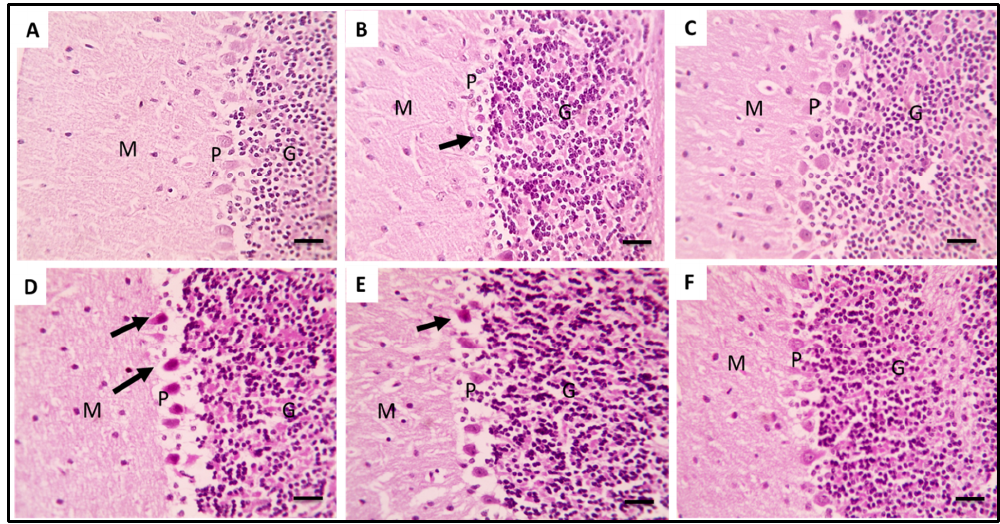
Figure 11. H&E-stained brain sections showing the cerebellum of the different groups. Normal neu- rons were revealed in the control group (group 1, ( A )). Sections from the group that received LPS (group 3, ( B )) showed a severe loss of purkinje neurons (black arrow). Sections from the treated group with RVS (group 4, ( C )) showed normal purkinje neurons. Sections from the treated group with SPE 100 mg/kg (group 5, ( D )) showed markedly degenerated purkinje neurons (black arrows). Sections from the treated group with SPE 200 mg/kg (group 6, ( E )) showed a few degenerated purkinje neurons (black arrow). Sections from the treated group with SPE 300 mg/kg (group 7, ( F )) showed normal purkinje neurons ( × 400). The letters G, P, and M stand for granular layer, purkinje layer, and molecular layer,